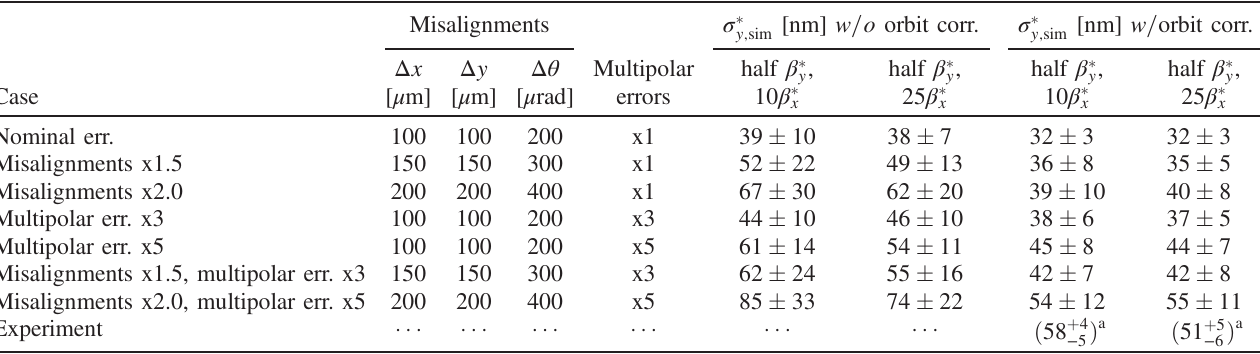
TABLE IV. Mean and standard deviation of the IP vertical beam size obtained from the tuning simulations for half β (cid:1) y , 10 β (cid:1) x ( 10 × 0 . 5 ) and half β (cid:1) y , 25 β (cid:1) x ( 25 × 0 . 5 ) optics for various sets of machine